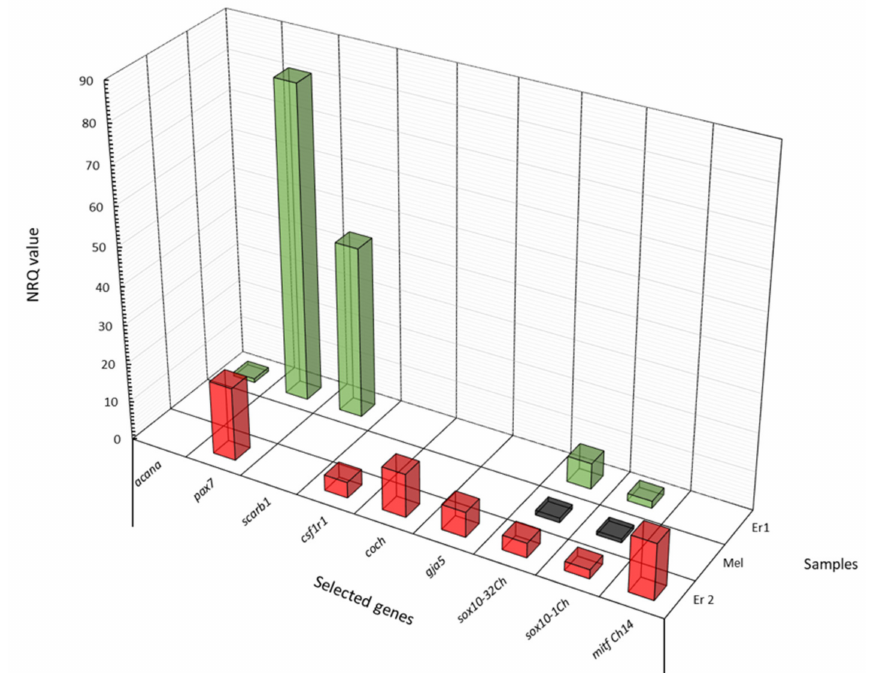
Figure 5. Gene expression patterns of three chromatophore samples: red bars—subtype 2 ery- throphores (Er2) isolated from a red-spotted skin region; dark grey—melanophores isolated from a black-spotted skin region; green—subtype 1 erythrophores isolated from a black-spotted skin region. Fold changes are expressed as the ratio of gene expression after normalisation to the reference gene. Selected genes have previously been shown to be strongly upregulated in brown trout red-spotted skin regions compared to black-spotted and background skin regions